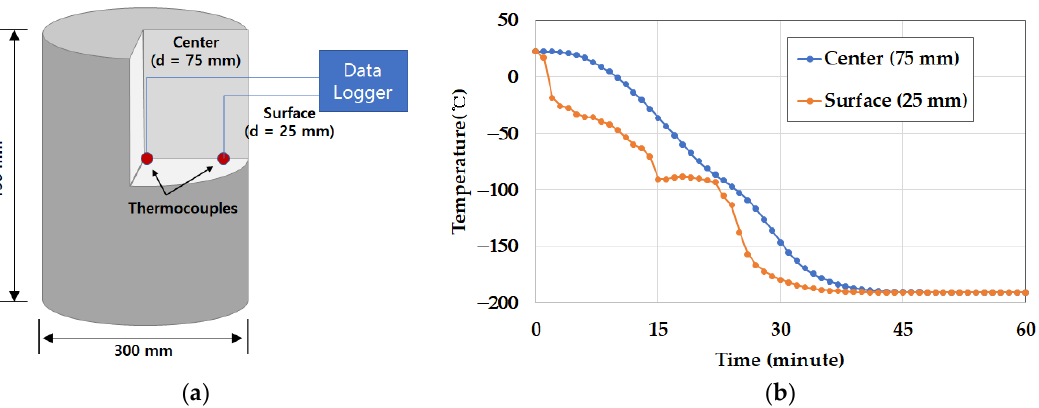
Figure 8. Thermocouple installation and temperature variation: ( a ) sample size and sensor location and ( b ) temperature variation over time. Table 11. Test results of compressive strength, elastic modulus, poisson ratio and absorption.